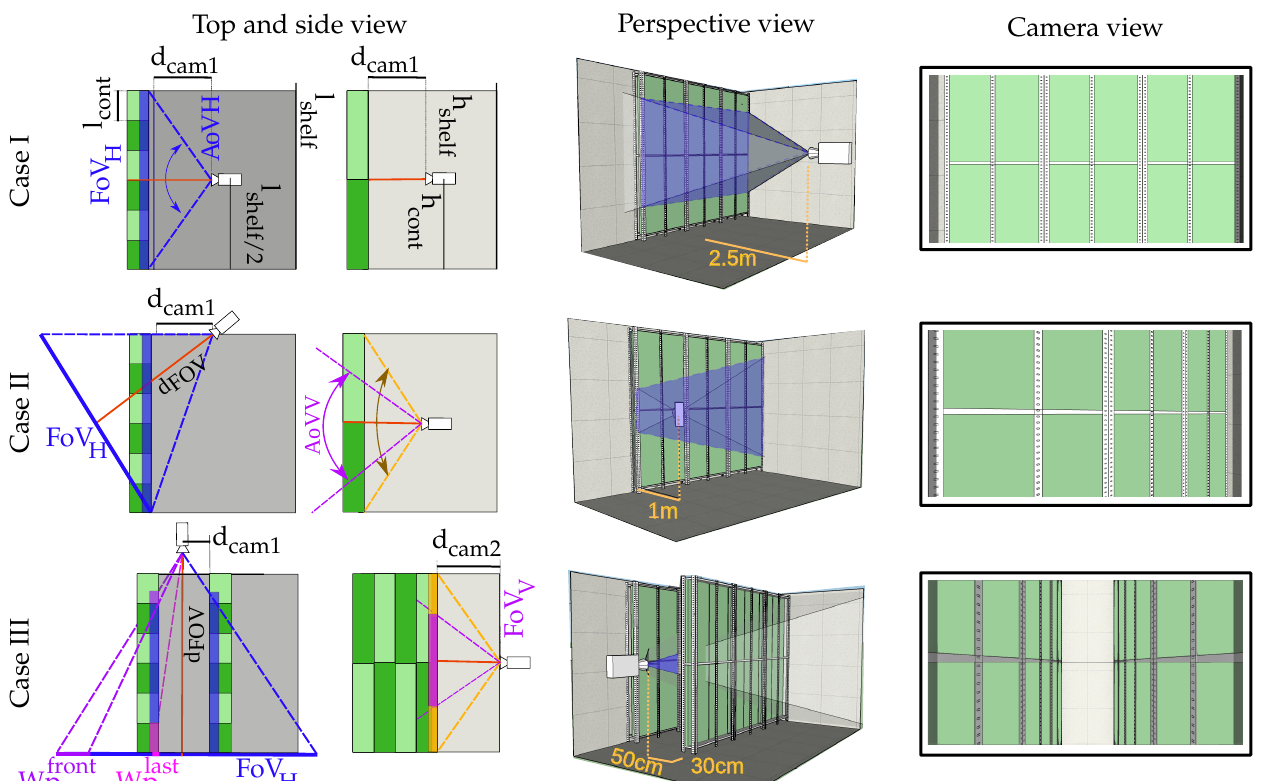
Figure 5. Three different cases proposed for the plant distribution